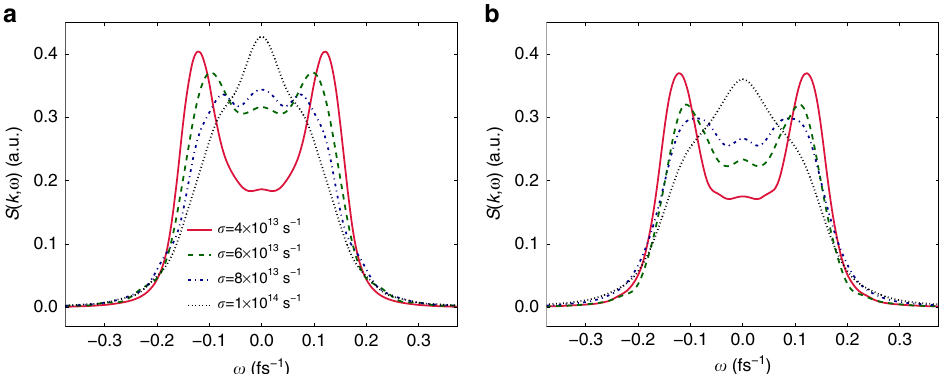
Figure 2 | Sensitivity of the dynamic ion–ion structure factor on the Langevin friction parameter r . Data were obtained from orbital-free density functional theory (OF-DFT) simulations ( a ) and fully classical MD simulations ( b ) for warm dense aluminium at T e ¼ T i ¼ 3.5eV and r ¼ 5.2gcm (cid:2) 3 . The classical and orbital-free approaches both exhibit the same trend; that is, the central Rayleigh line dominates the acoustic peaks at the largest value of s considered, whereas the central peak disappears altogether at lower values.